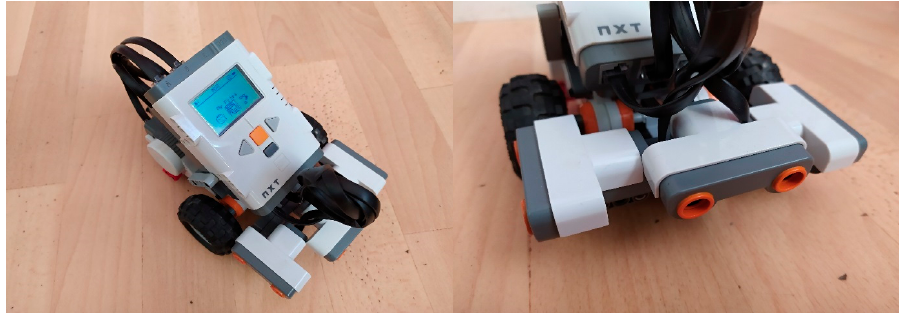
Figure 2. The robot model used three ultrasonic sensors in the